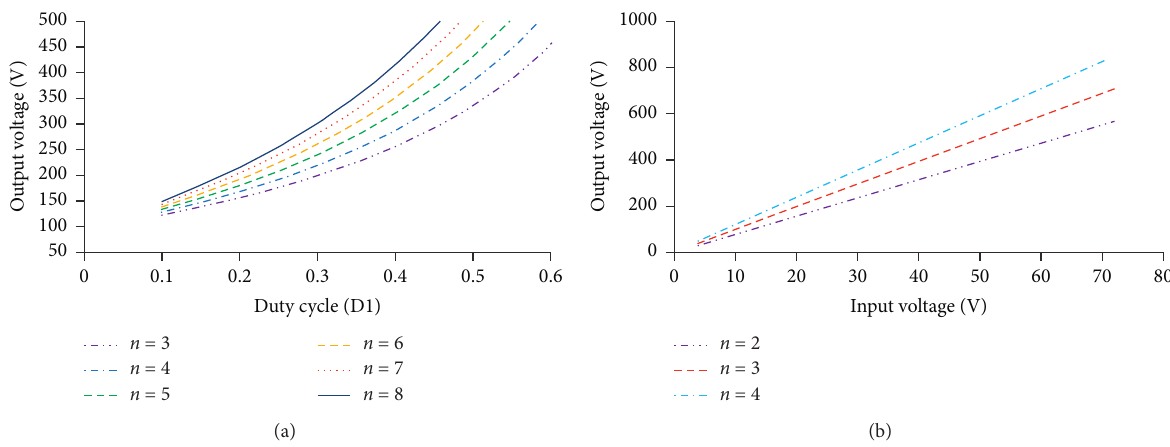
Figure 7: (a) Converter output vs duty cycle ( d